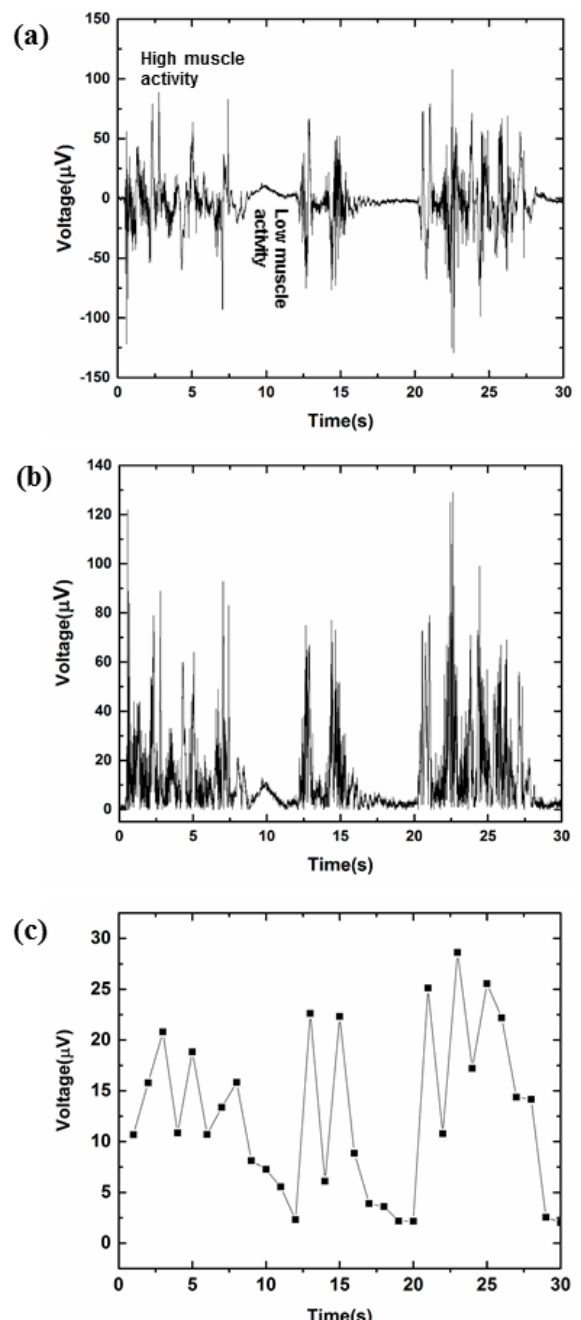
Figure 8. ( a ) Original signal obtained from forearm while driving; ( b ) Rectified EMG signal; ( c ) Av- erage calculated every one second, while the dotted line represents the threshold set for driver drowsiness